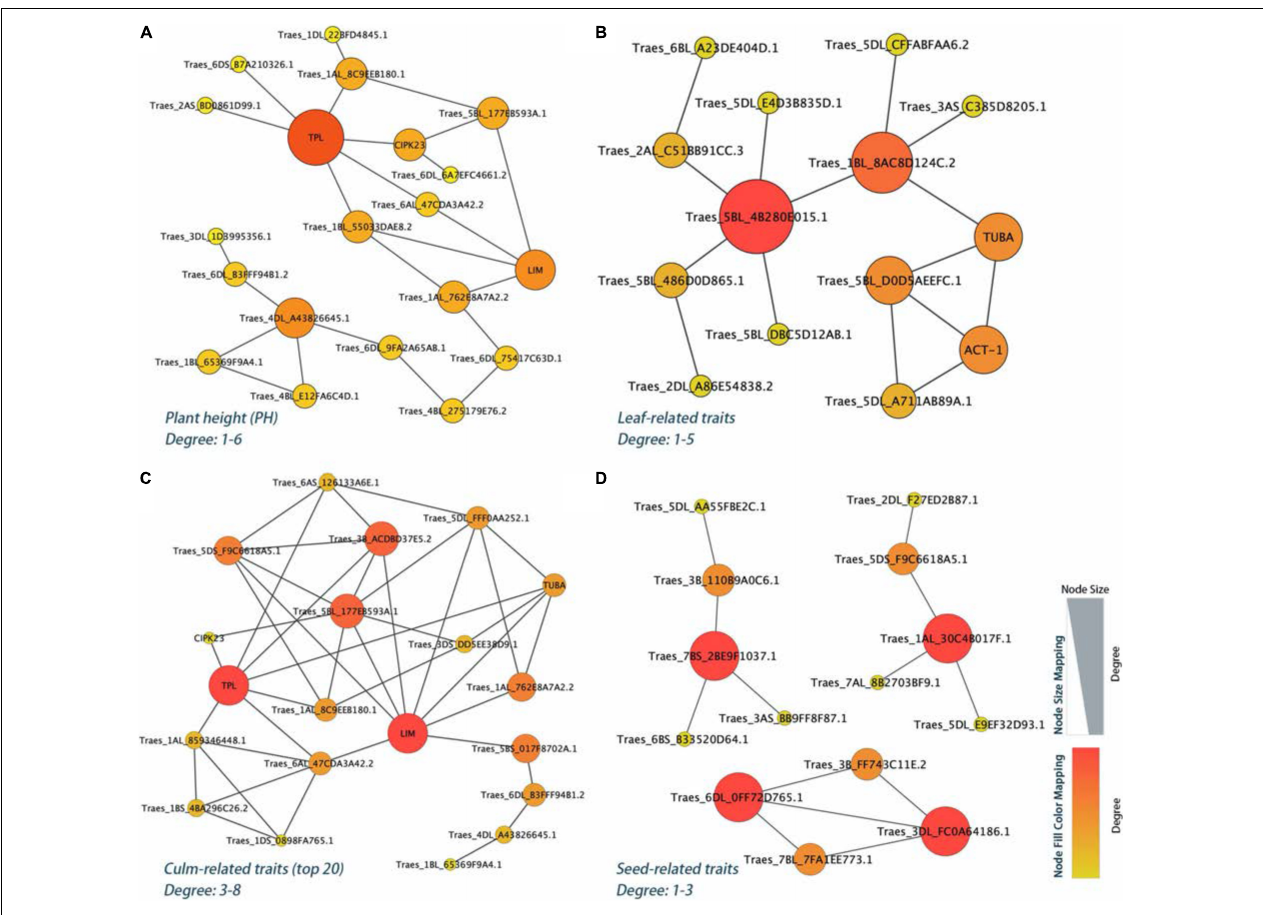
FIGURE 6 | The PPI regulatory network for the yield-related candidate genes in E. sibiricus . (A) Plant height (PH) traits. (B–D) Leaf-, culm-, and seed-related traits,